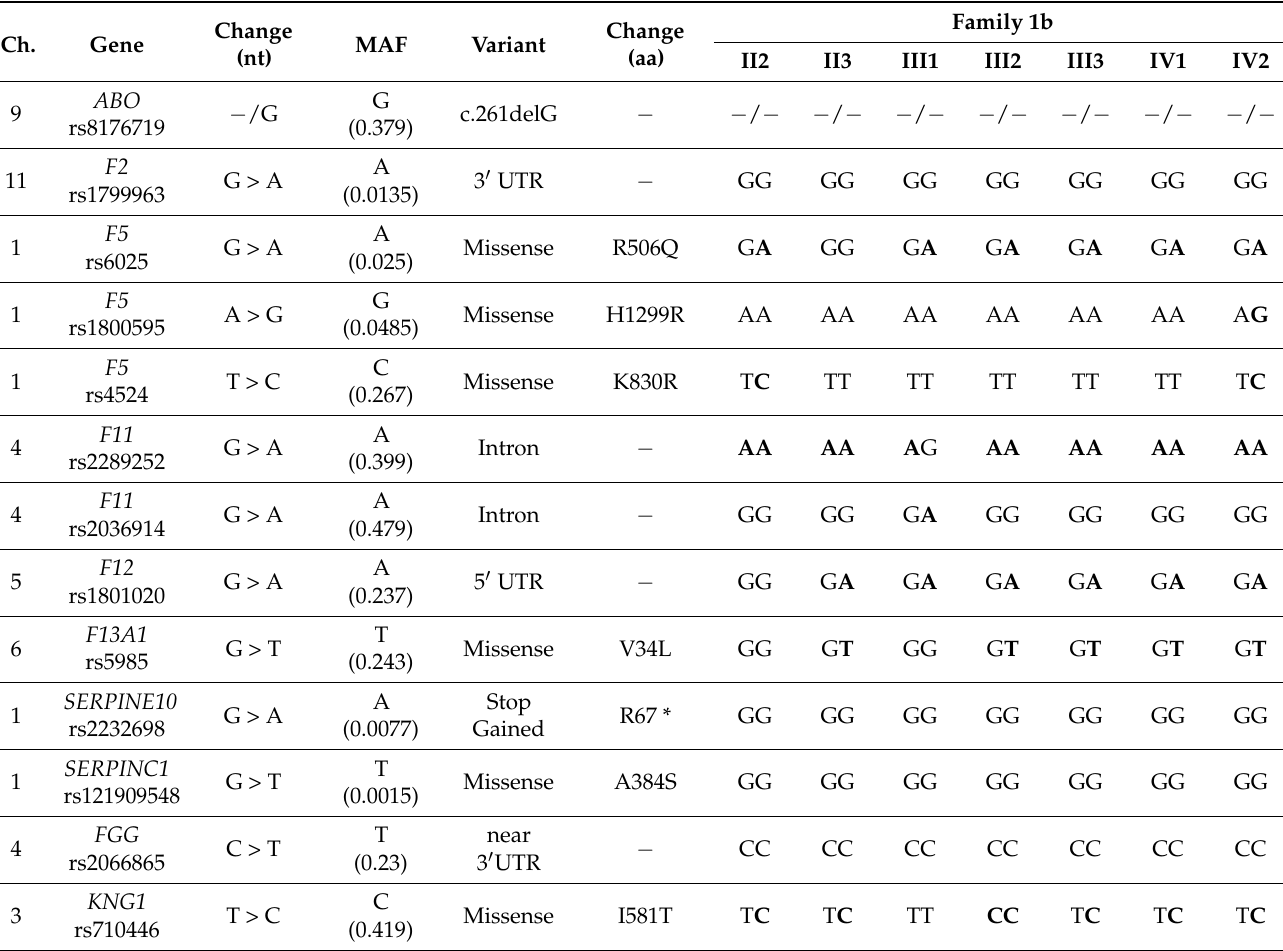
Table 1. Genotyping on selected SNPs in the members of Family